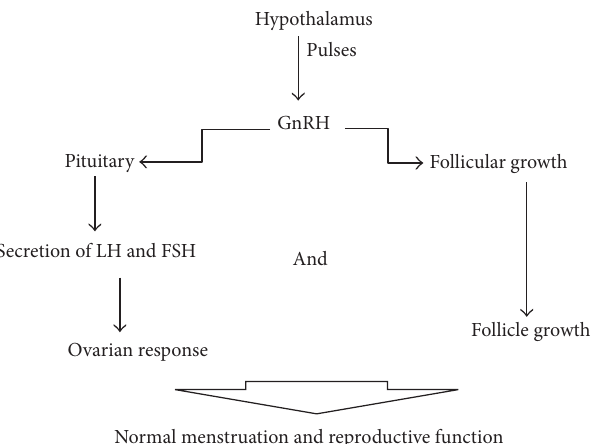
Figure 2: Physiological status of GnRH pulsatile secretion.